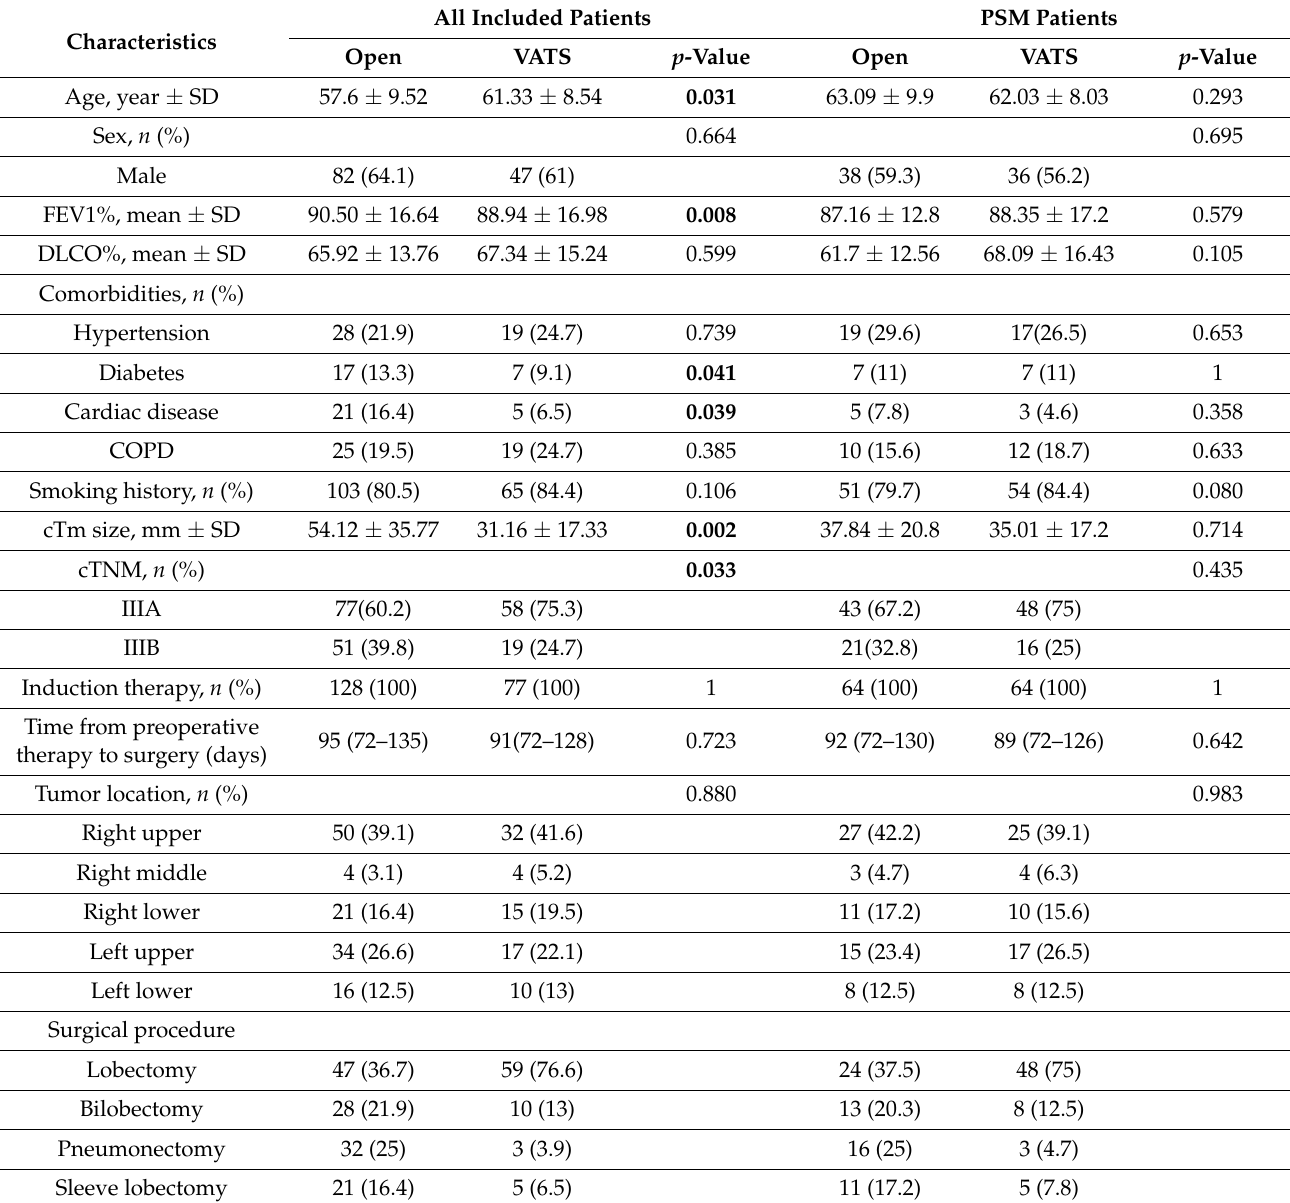
Table 1. Patient characteristics for all included patients and PSM